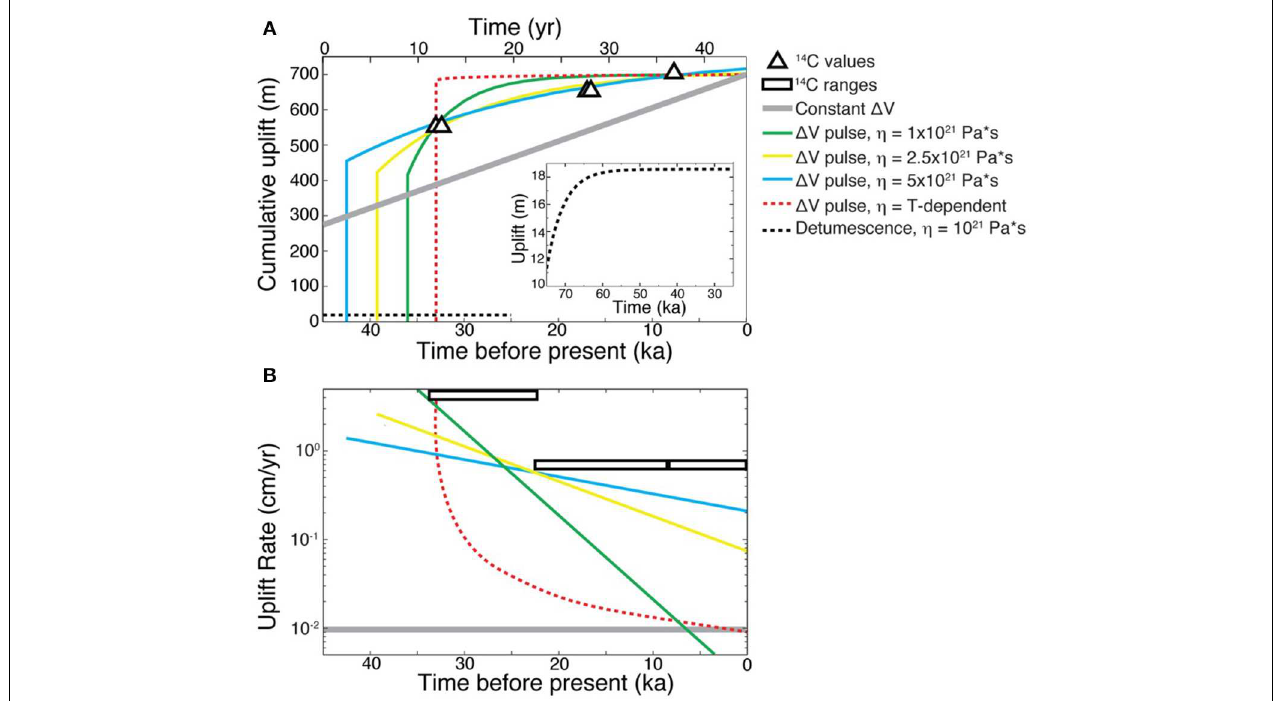
14 C dates are indicated by white triangles and the white rectangles respectively. While detumescence related uplift (inset of B ) operates on a similar timescale to the uplift due to volume change, the uplift rate due to detumescence is significantly lower than that of the volume change, with the maximum uplift of 9m being reached about 10 ky after onset. Volume change, 1 V, models assume a single pulse of magma at 33.7ka for the temperature-dependent viscosity, 36ka for the 1 × 10 21 Pa s viscosity, at 39.25ka for the 2 . 5 × 10 21 Pa s viscosity and 42.5ka for the 5 × 10 21 Pa s